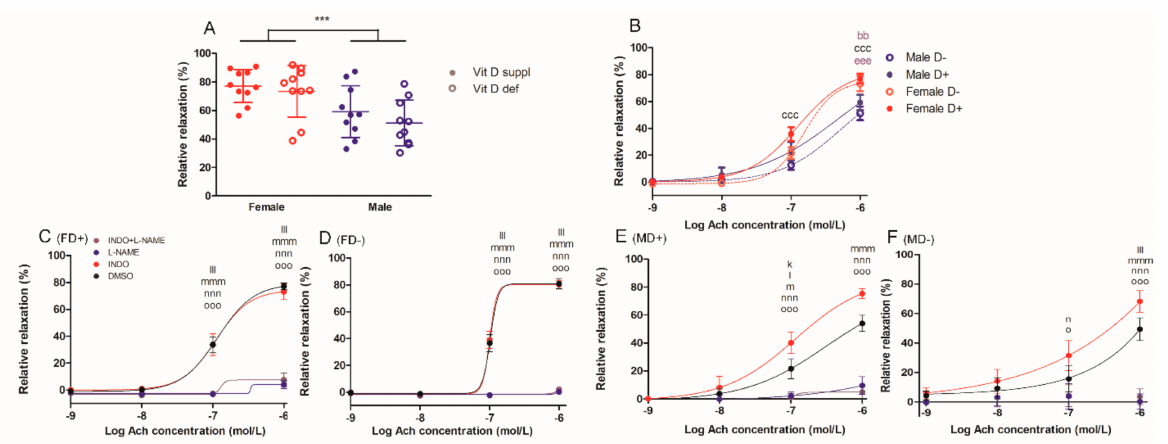
Figure 2. Relaxation ability of isolated carotid artery segments: ( A ) acetylcholine (Ach)-induced relaxation in the four experimental groups at 10 − 6 mol/L Ach concentration. Male gender was associated with less pronounced relative relaxation. Data are shown as individual data points; horizontal lines represent mean ± SD. Two-way ANOVA; factors: gender,